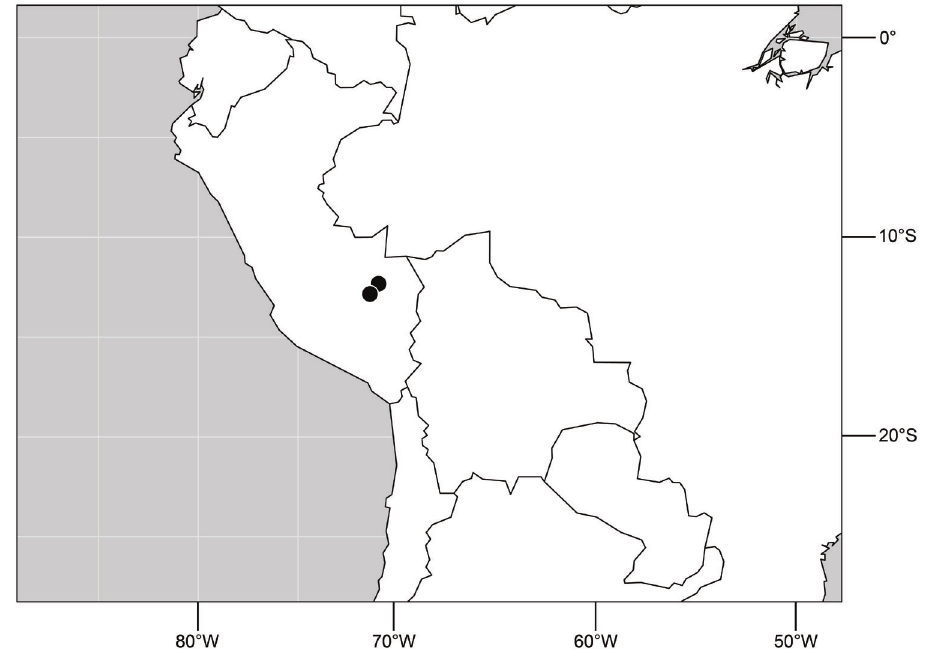
Figure 17. Distribution of Hydrochasma digitatum sp.